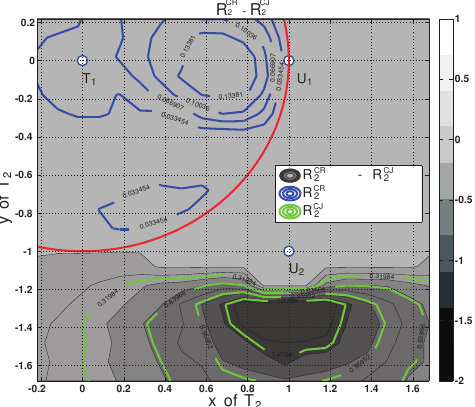
Figure 5: Achievable secondary rate R IN depending on the location of T 2 . CJ as 2 − R 2